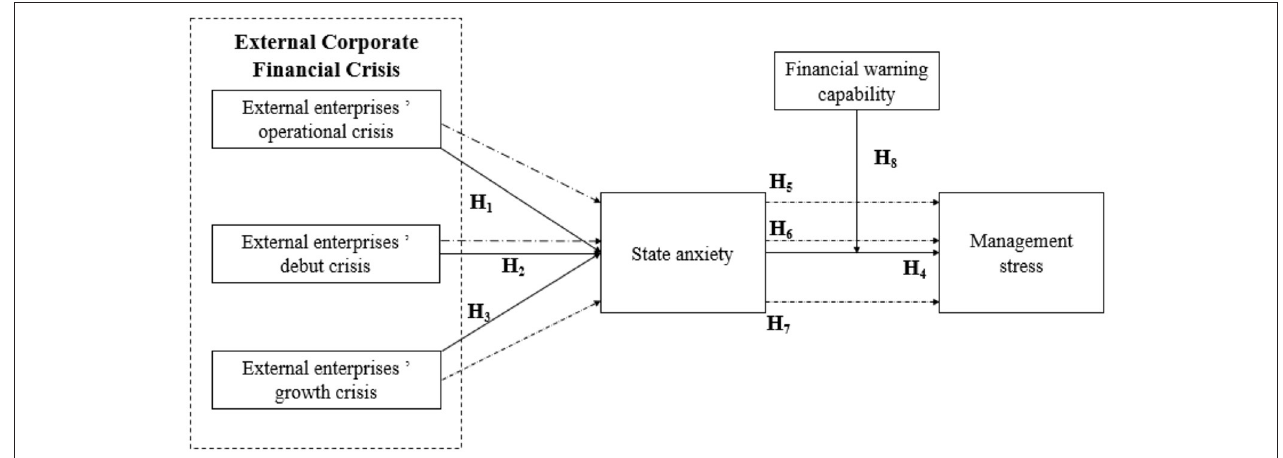
FIGURE 1 | Research